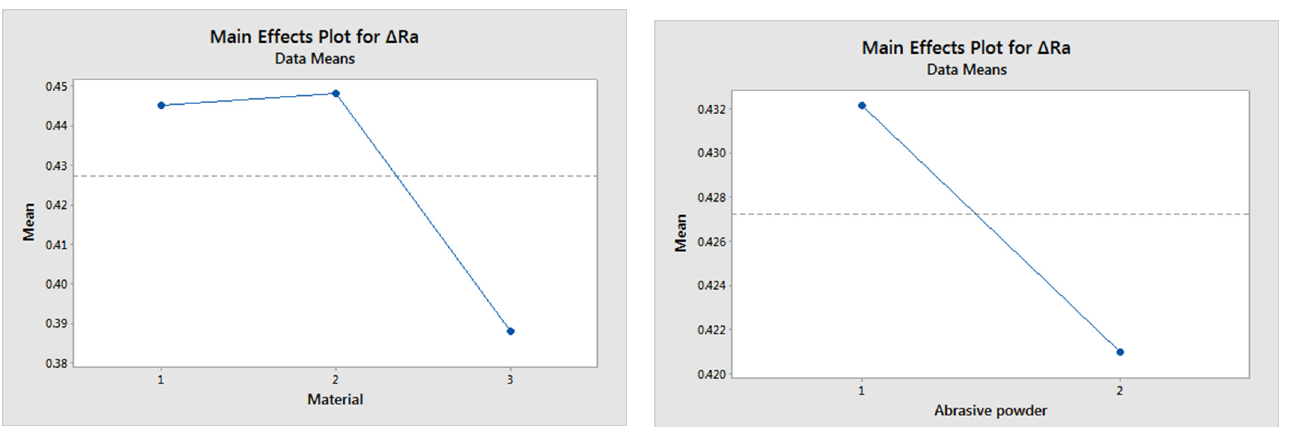
Fig. 6. The effect of MAF process on three different materials (1 =AZ31, 2 =Steel 316Lvm, 3= Ti-6Al-4V).